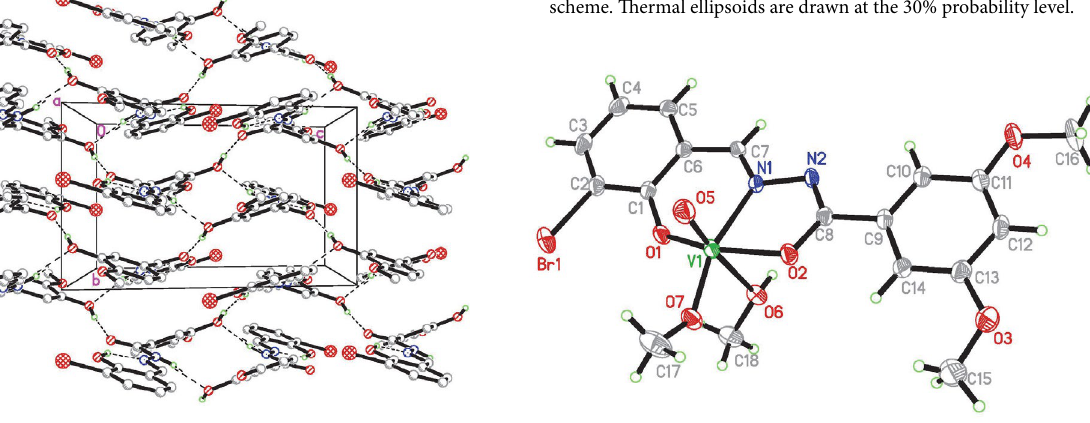
Figure 4. A perspective view of complex 2 with the atom label- ing scheme. Thermal ellipsoids are drawn at the 30% probability level.